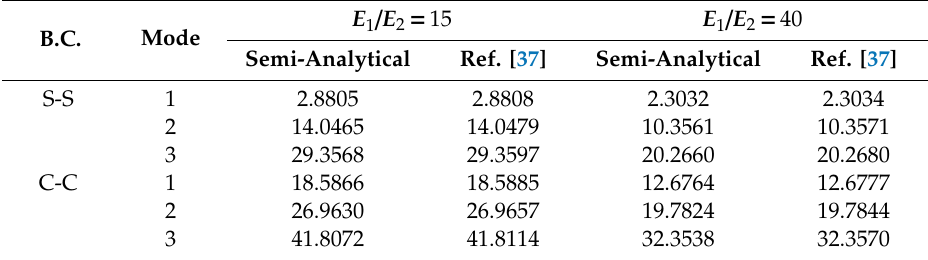
Table 3. Comparisons of natural frequencies for laminated circular arches ( θ 0 = π / 2, L / H = 10).